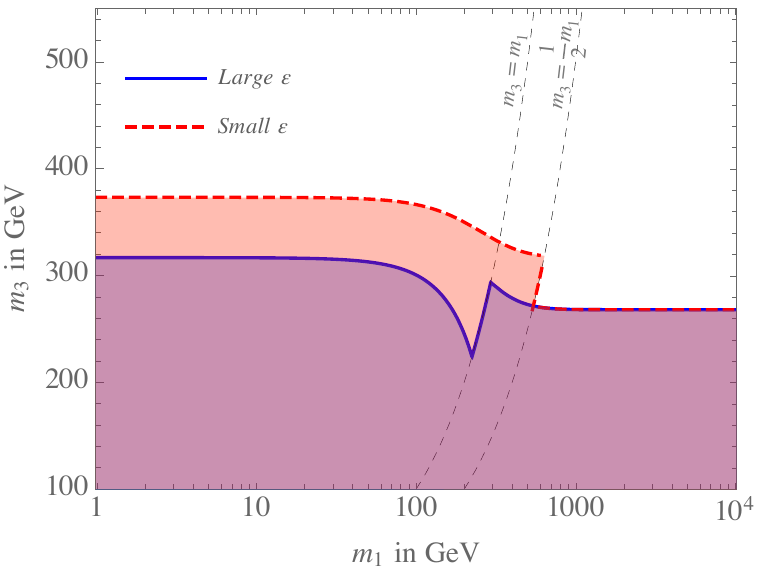
Figure 7 . 95% probability exclusion regions in the ( m 1 , m 3 ) plane from collider searches of events with three leptons and missing energy (first row of table 6). The dashed red curve assumes a value of ε sufficiently small to have dark photon decays outside the detector, while the solid blue one applies for larger values of ε . Both curves assume m 1 = 2 m γ . The gray thin dashed lines mark D the different kinematic regions of table